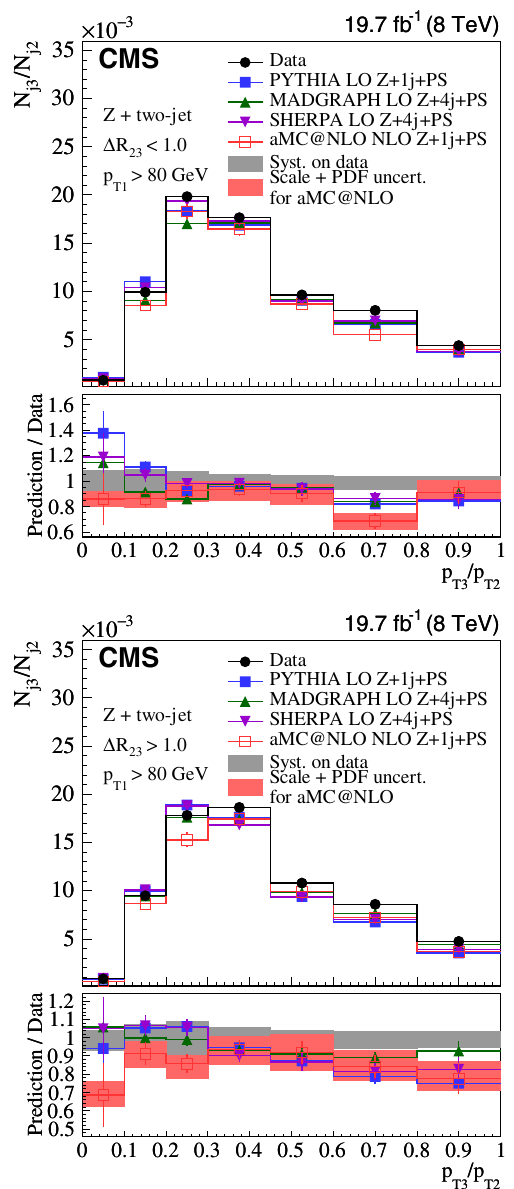
Fig. 7 Z + two-jet events at Δ R 23 for soft radiation ( p T3 ation ( p T3 / p T2 > 0 . 6)